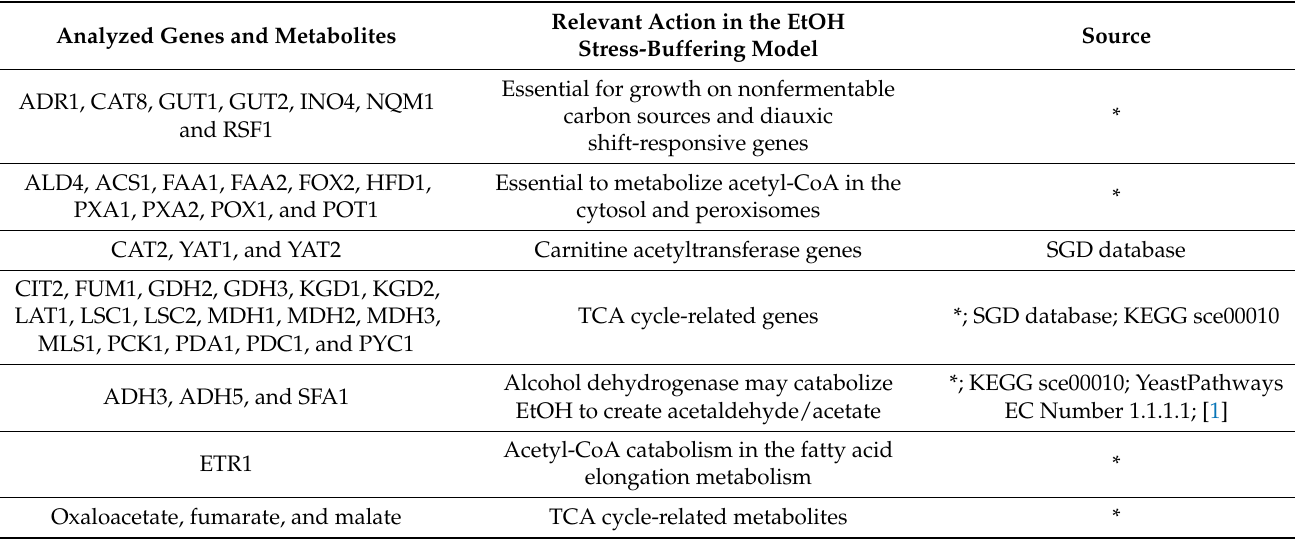
Table 3. Genes related to the EtOH stress-buffering model. *: Citations and description of genes and metabolites are available in the “Supplementary Text” (“Discussion”, topic